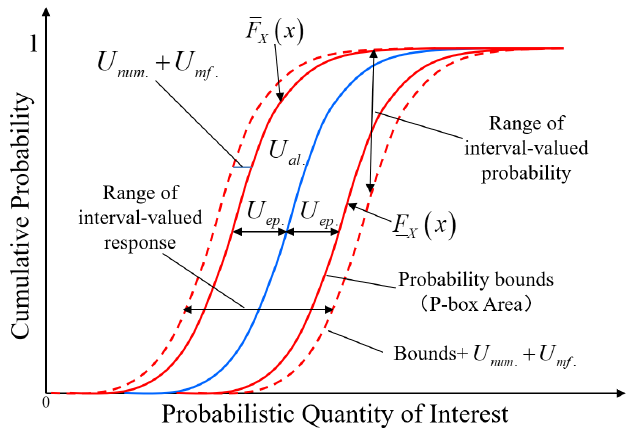
Figure 6. Schematic of the probability box [41].